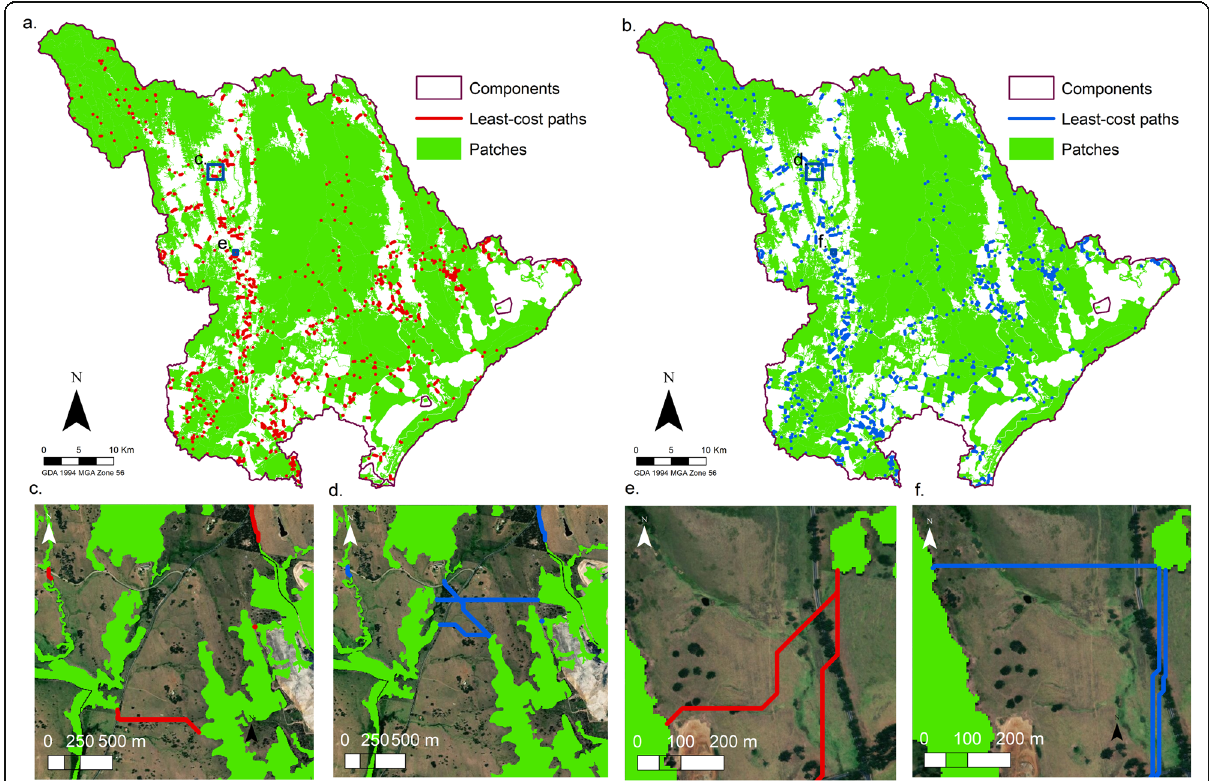
Fig. 3 Habitat patches, least-cost paths, and component boundaries of the Karuah-Myall catchments: a , c , e with the gap crossing layer characterising movement between scattered trees and b , d , f without the gap crossing layer. c – f Insets showing the characteristics of the least-cost